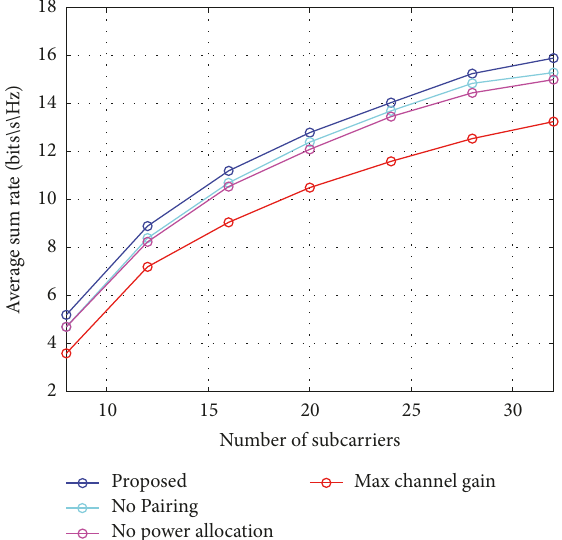
Figure 3: Operator’s profits versus different number of users.